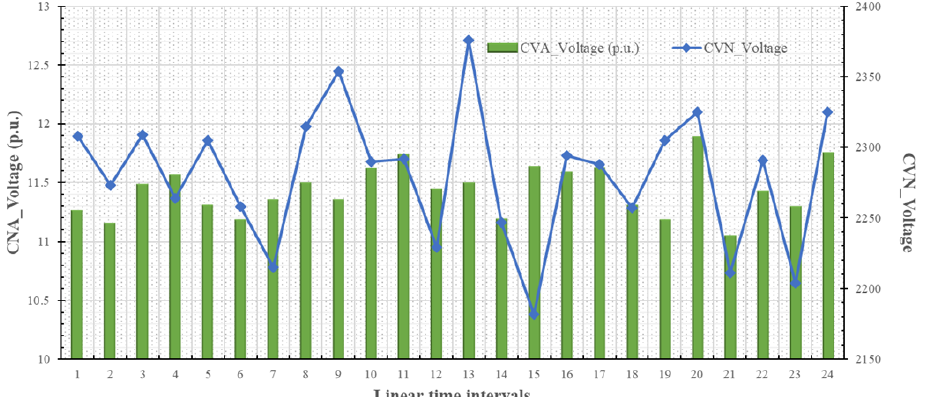
Figure 9. Over-limit numbers and amounts of traditional optimal power flow on nodal voltages.